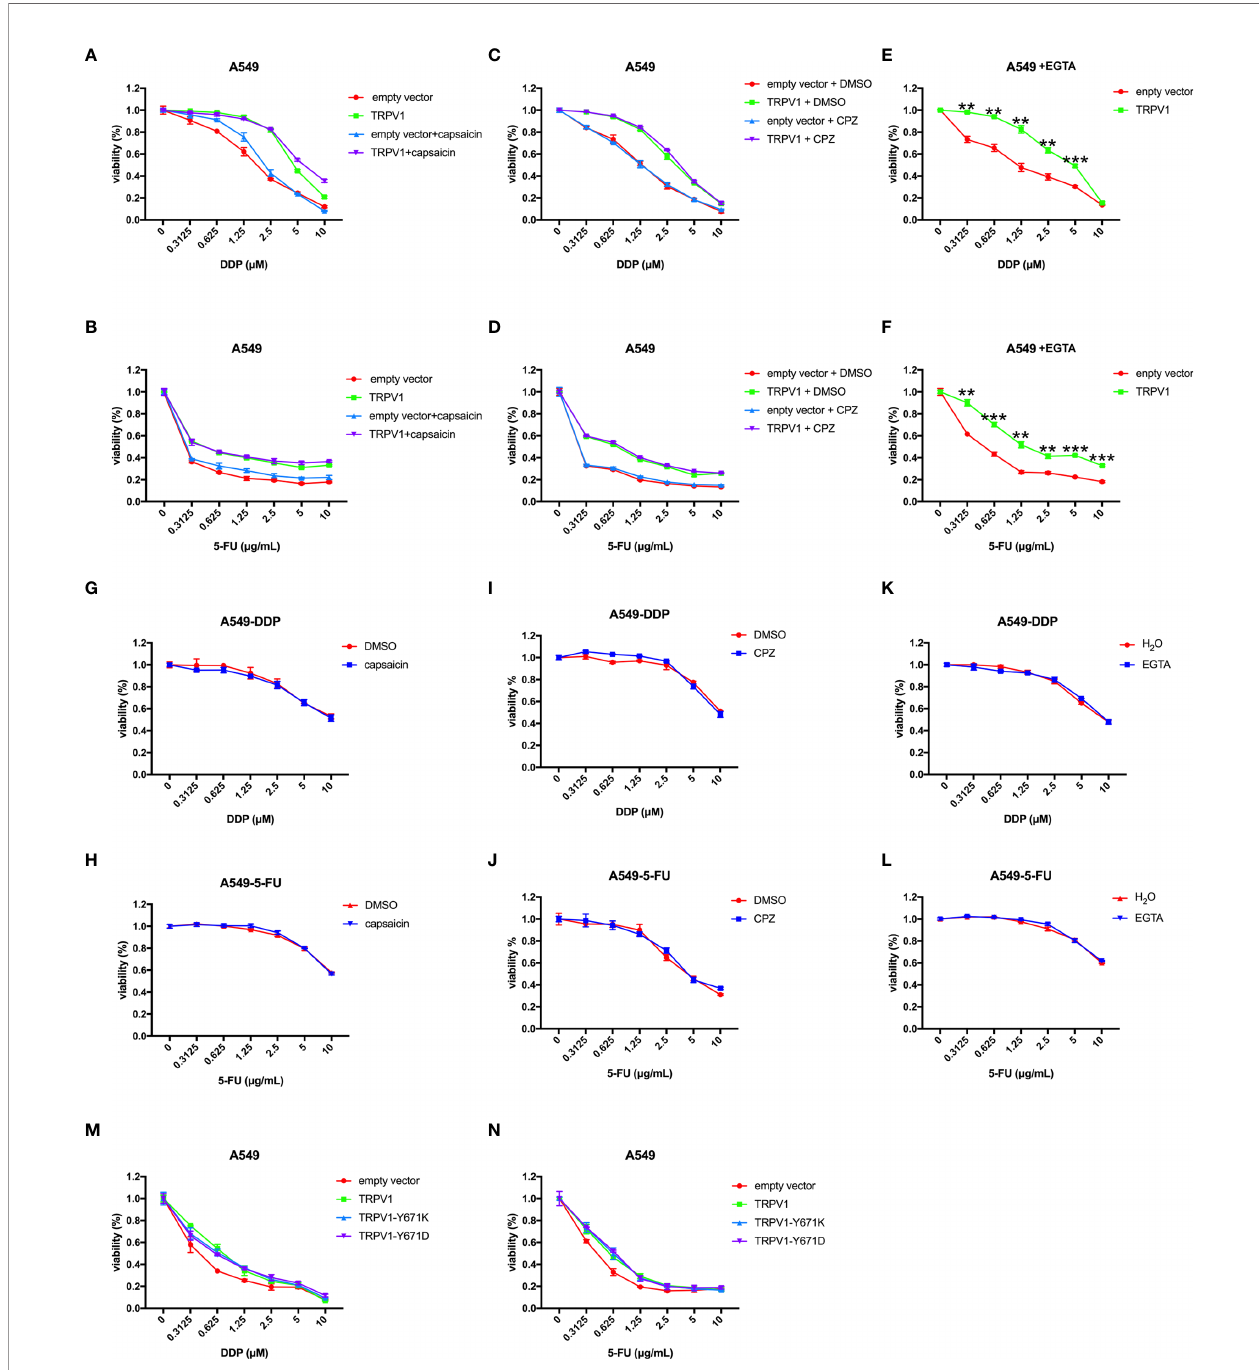
FIGURE 4 | TRPV1 overexpression induced DDP and 5-FU resistance independent of its channel function. (A, B) CCK-8 assay showing that capsaicin treatment has no effect on DDP or 5-FU sensitivity and resistance induced by TRPV1 overexpression. (C,D) CCK-8 assay showing that capsazepine treatment has no effect on DDP or 5-FU sensitivity and resistance induced in A549 cells by TRPV1 overexpression. (E, F) CCK-8 assay showing that TRPV1 overexpression still decreased DDP and 5-FU sensitivity of A549 cells cultured in the presence of EGTA. (G, H) CCK-8 assay showing that capsaicin treatment has no effect on DDP or 5-FU sensitivity of A549-DDP/5-FU resistant cells. (I, J) CCK-8 assay showing that capsazepine treatment has no effect on DDP or 5-FU sensitivity of A549-DDP/5-FU resistance cells. (K, L) CCK-8 assay showing that EGTA treatment has no effect on DDP or 5-FU sensitivity of A549-DDP/5-FU resistant cells. (M, N) CCK-8 assay showing that TRPV1 overexpression induced DDP or 5-FU resistance independent of the calcium signaling pathway. Three independent experiments were performed. Statistical signi fi cance was determined using Student ’ s t test. Data represent mean ± SEM. ** P < 0.01. *** P <